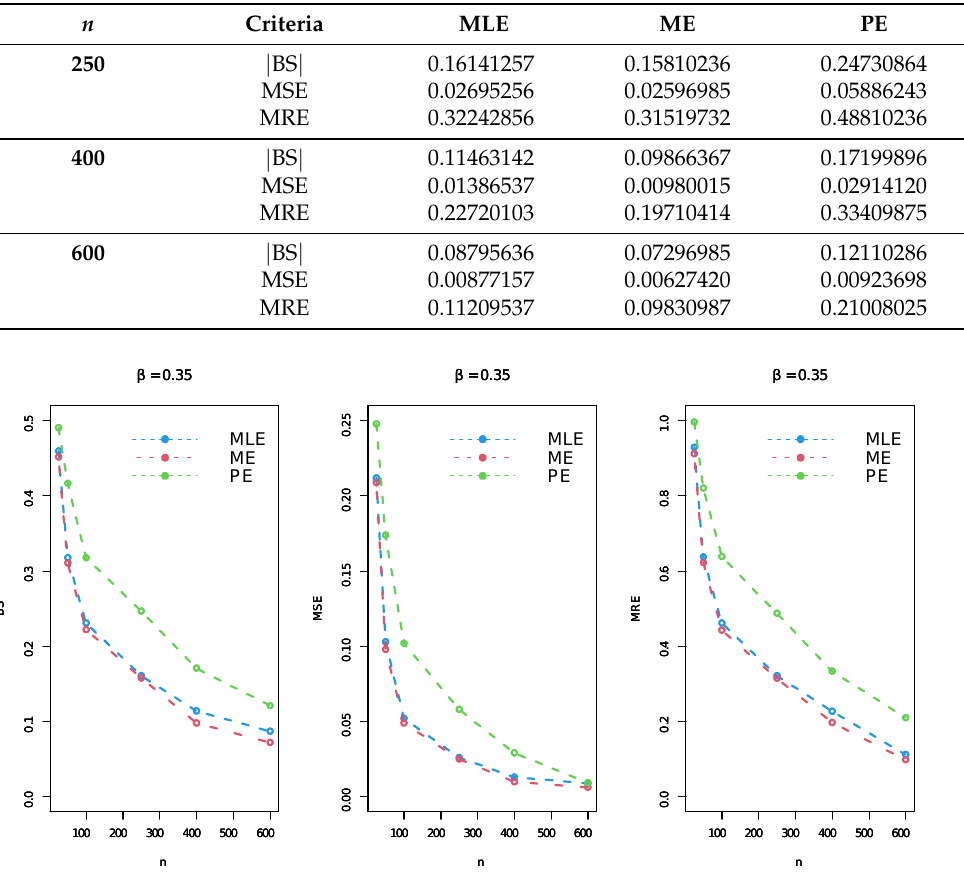
Table 4. Simulation results for (cid:12) = 0 : 35 .